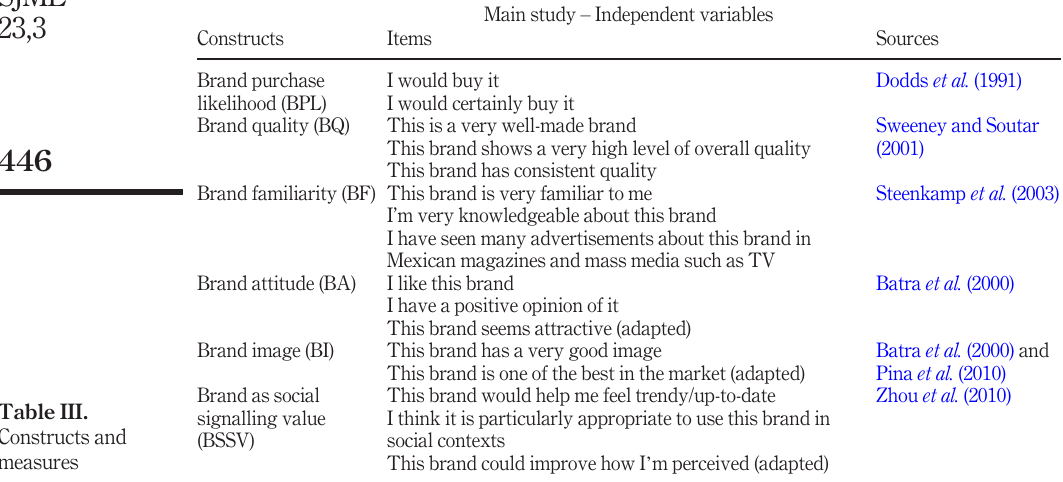
Table III. Constructs and measures